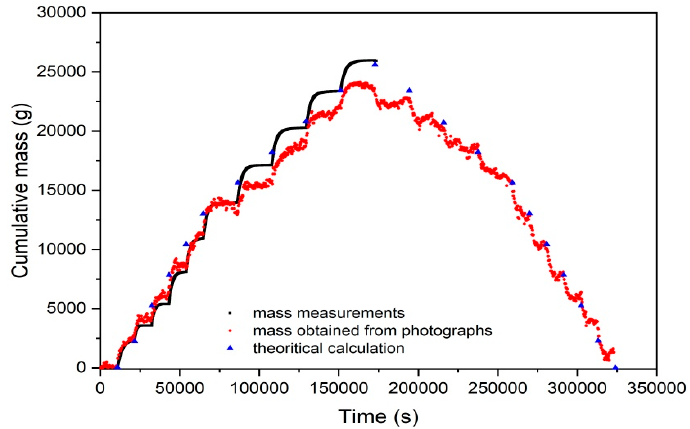
Figure 8. Evolution of the cumulative mass leaving and entering the flow tank: comparison between mass measurements (black square symbols), values obtained from photometric procedure (red circle symbols), and theoretical values (blue triangular symbols).